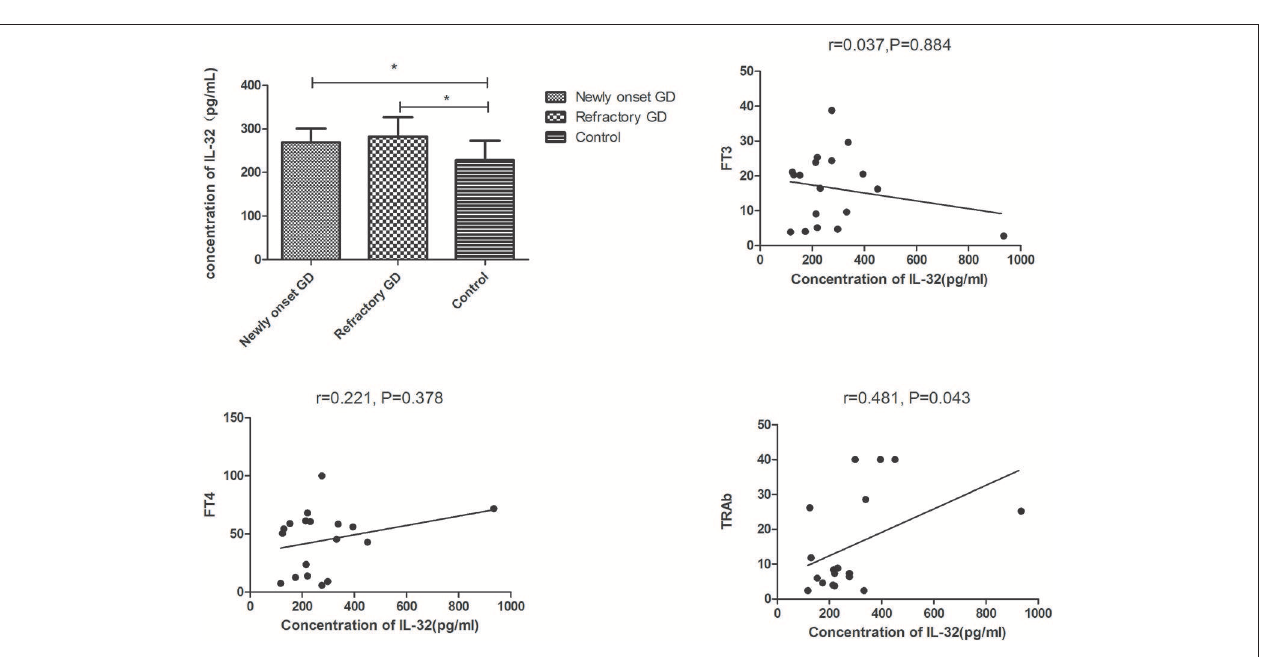
FIGURE 4 | Subgroup analysis of the concentration of IL-32 in the plasma of newly onset GD patients and refractory GD patients. IL-32 concentration in both newly onset GD patients and refractory GD patients was higher than that in controls; IL-32 mRNA expression in refractory GD patients was positively correlated with TRAb. In refractory GD patients, no correlation was found between IL-32 concentration and FT3 and FT4 (all * P >